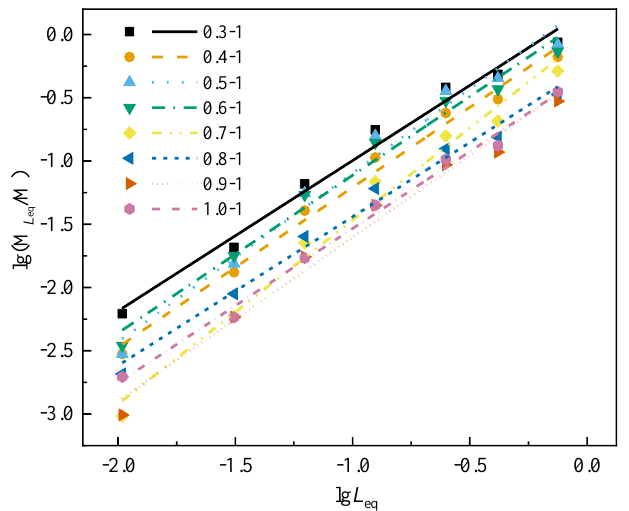
Figure 11. lg ( M L eq / M )—lg L eq curve of fractal dimension of specimens with different l / d .